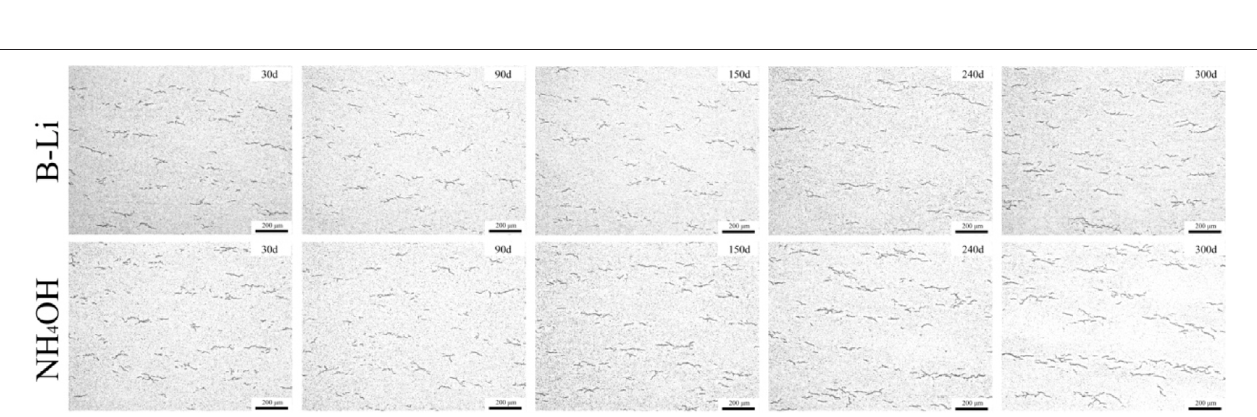
FIGURE 7 | Hydrides in the matrix of the specimens after 30, 90, 150, 240, and 300 days of the test in the two types of solutions.